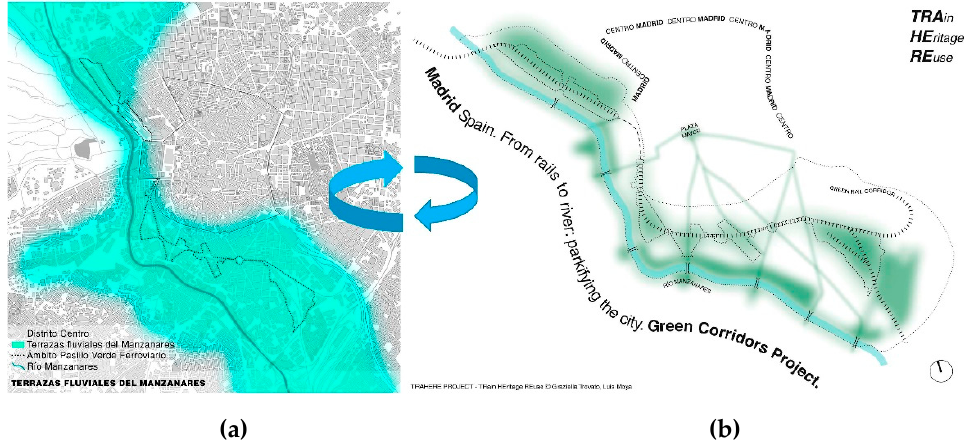
Figure 5. Two diagrams that synthesize the circularity proposal. ( a ) The scope of the PVF in the old fluvial terraces of the river. The following are distinguished: the downtown district, the area of the PVF, and that of the old terraces. ( b ) The proposal for the connection project between the PVF and Madrid Río “Towards a desirable circularity”. Source: TRAHERE’s own elaboration.